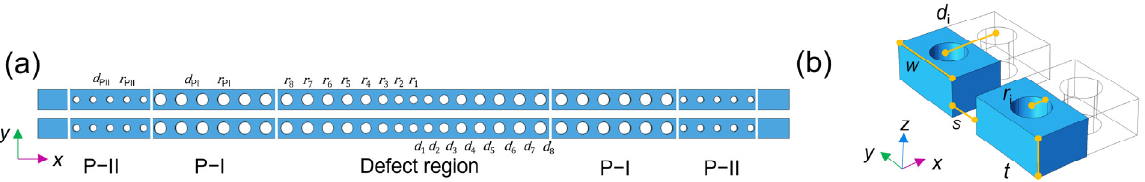
Figure 1. ( a ) Top view of the hetero-optomechanical crystal (OMC) zipper cavity. ( b ) Structural parameters in OMC unit cell.